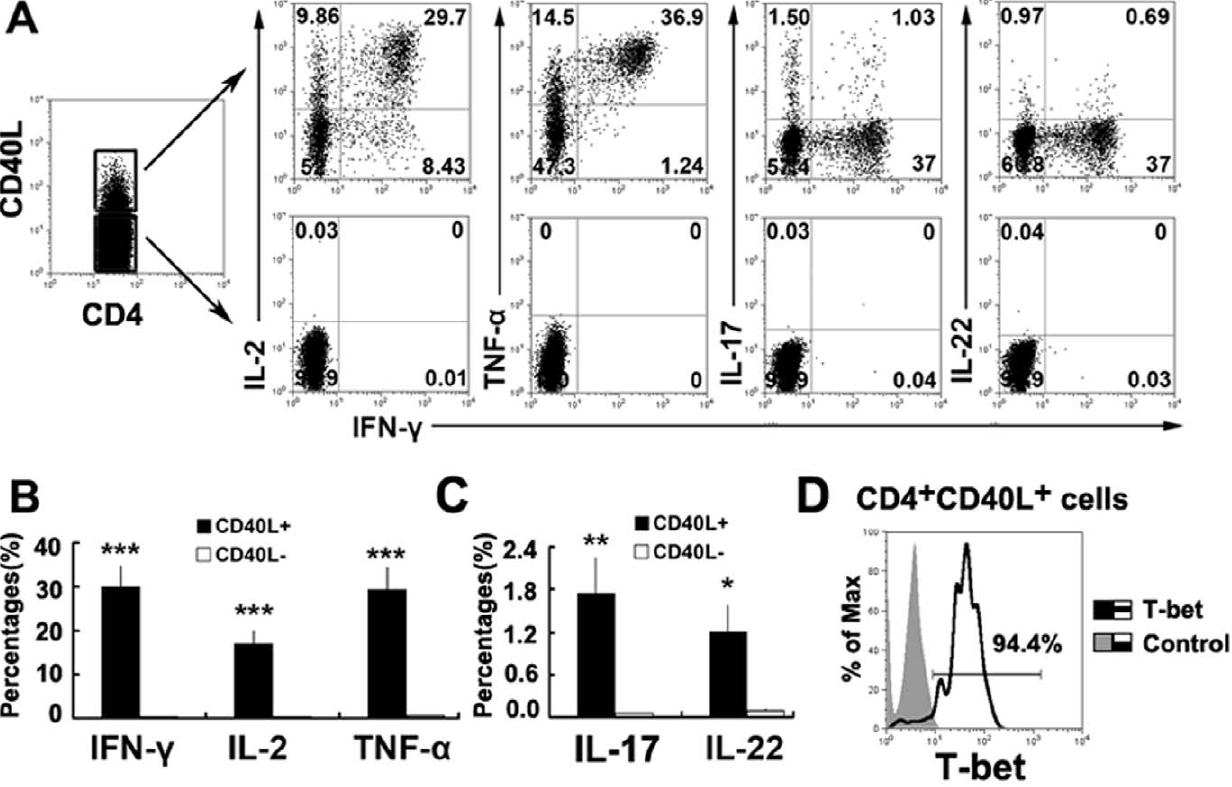
Figure 2. CD4 + CD40L + but not CD4 + CD40L 2 T cells express IFN- c , IL-2, TNF- a , IL-17 or IL-22 following MTB-specific stimulation. PFCs were stimulated with ESAT-6/CFP10 peptides, anti-CD28 and anti-CD49d mAbs. CD4 + CD40L + and CD4 + CD40L 2 cells were gated.(A) CD4 + CD40L + but not CD4 + CD40L 2 T cells express IFN- c , IL-2, TNF- a , IL-17 or IL-22. The numbers in the quadrants are the percentages of cells. (B) Ratio of IFN- c , IL-2, TNF- a , (C) IL-17 and IL-22 expression by CD4 + CD40L + or CD4 + CD40L 2 cells. Results shown are the mean 6 SEM from 12 to 21 independent experiments. * P , 0.05; ** P , 0.01; *** P , 0.001. (D) Histogram graph of T-bet expression by CD4 + CD40L + T cells. Filled histogram represents isotype control staining and open histogram represents T-bet staining. Data shown are representative of five independent